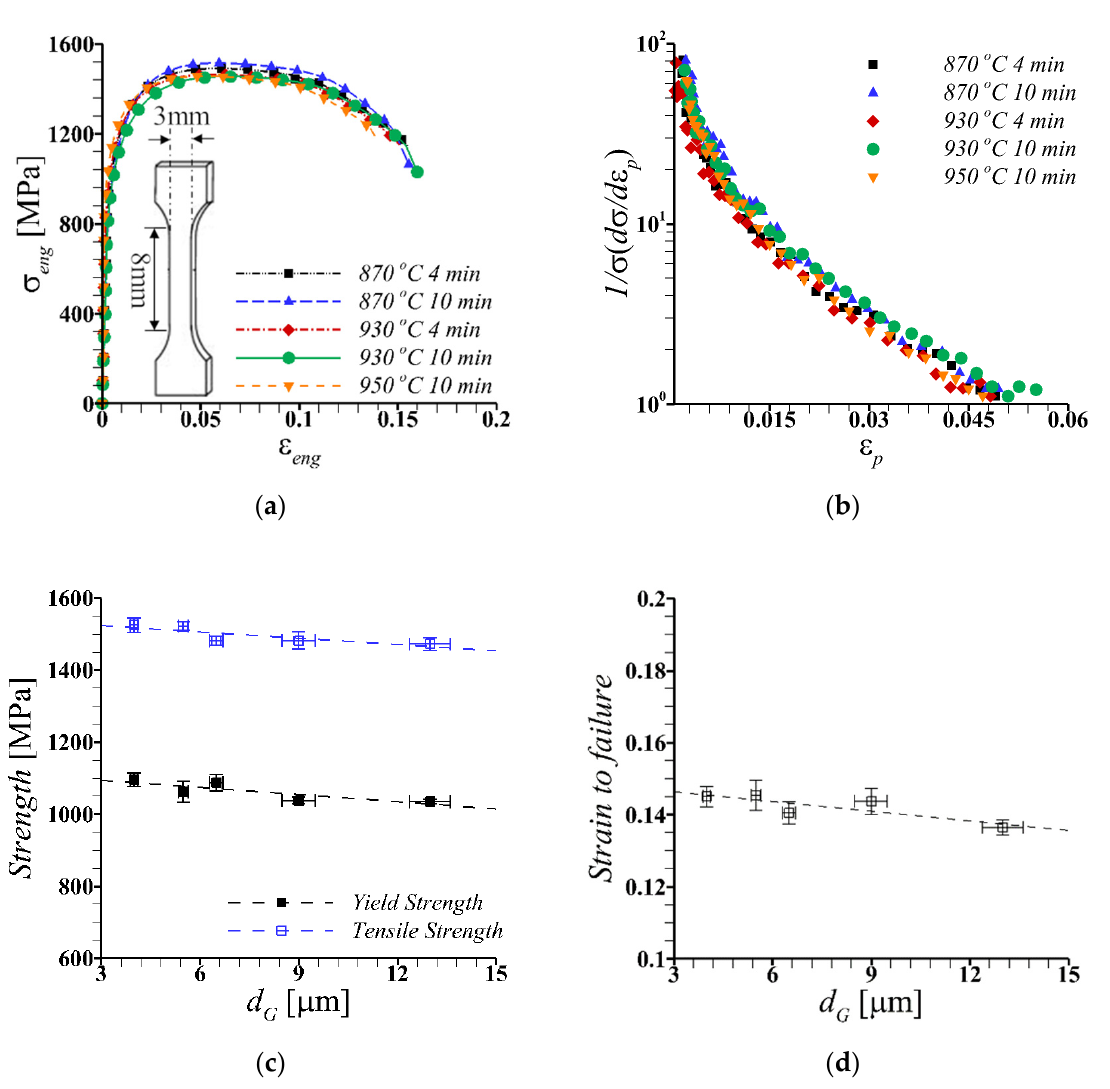
Figure 4. ( a ) Engineering stress–strain ( σ eng − ε eng ) response and ( b ) evolution of the true stress ( σ ) normalized strain- hardening rate, 1/𝜎 d σ / d ε p , with true plastic strain, ε p , obtained from the dog-bone specimens of the five heat-treated martensitic steel. ( c ) Variation in the yield and tensile strengths and that of the ( d ) plastic strain to failure with average prior austenite grain size, d G